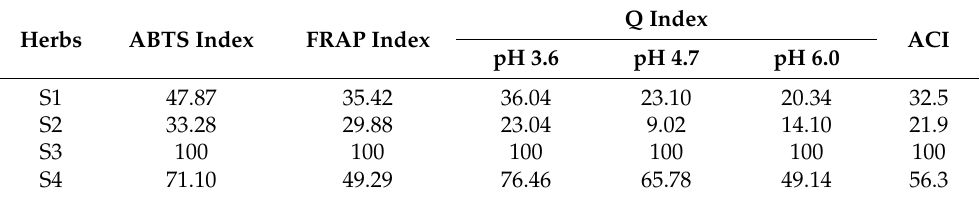
Table 3. Antioxidant potency composite index of aqueous plant extracts from four antioxidant capacity measures scaled to relative